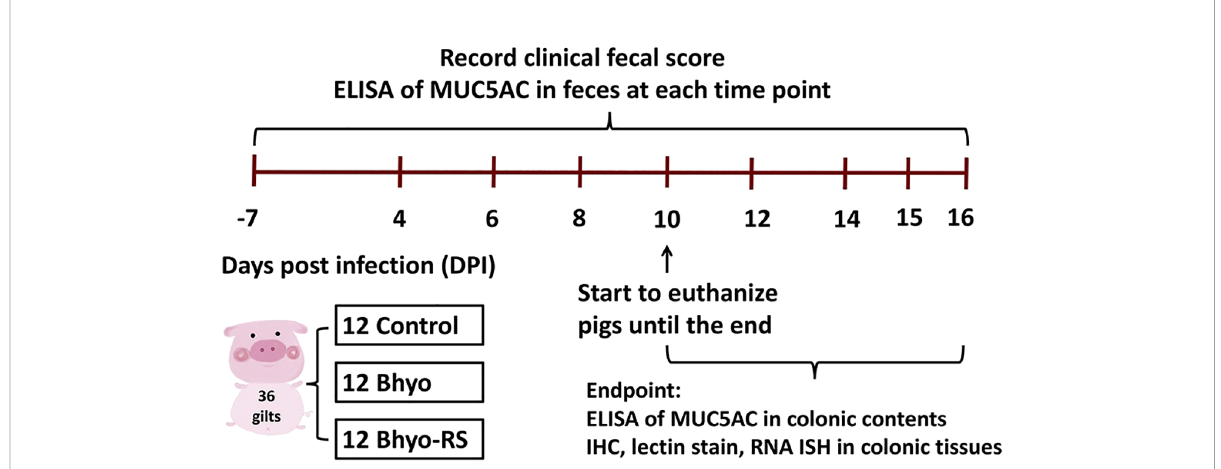
FIGURE 1 Study design. ELISA to detect MUC5AC detection in feces was performed on samples obtained from DPI-7, and on samples obtained every other day from DPI 4 to the day of euthanasia or at the end of the study on DPI 16. Formalin- fi xed, paraf fi n-embedded tissue samples from the apex of the spiral colon were used for IHC, lectin stain, and